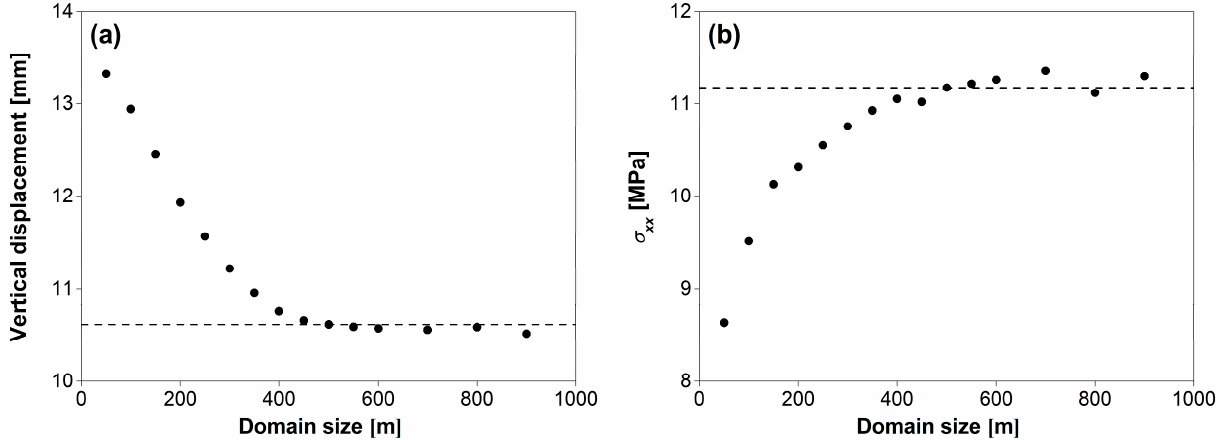
Figure 12. Variation of the ( a ) vertical displacement ( z ‐ direction) and ( b ) horizontal stress σ xx at point N (see Figures 9a and 10) as a function of the domain size d (for m = 0.5 m).